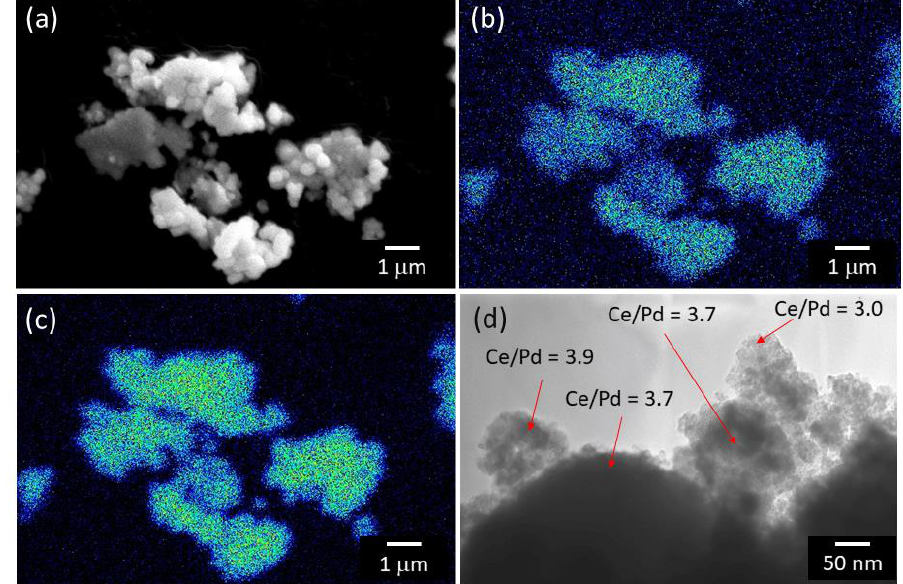
Figure 6. Microscopic observation of prepared PdCe4. ( a ) Secondary electron image and elemental mapping of ( b ) Pd and ( c ) Ce obtained by SEM − energy dispersive X-ray spectroscopy (EDS). ( d ) Transmission electron microscopy (TEM) image with atomic ratios obtained by EDS.